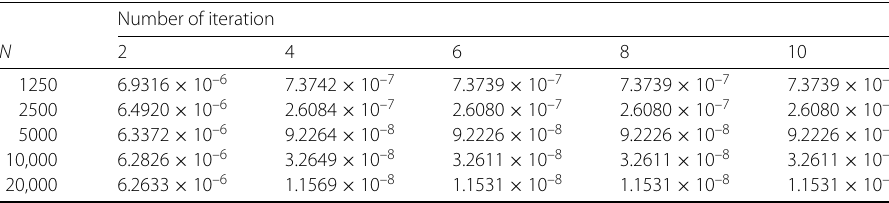
Table 1 Numerical comparison of the errors in Example